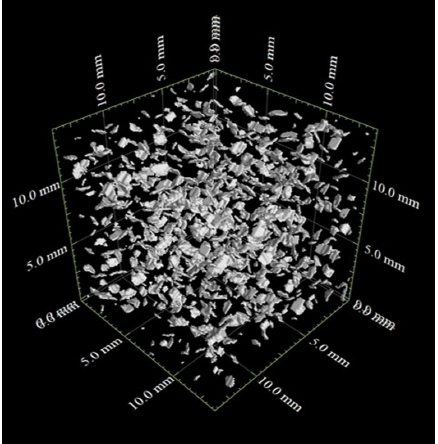
Figure 9. Contact surface between particles in three-dimensional view.